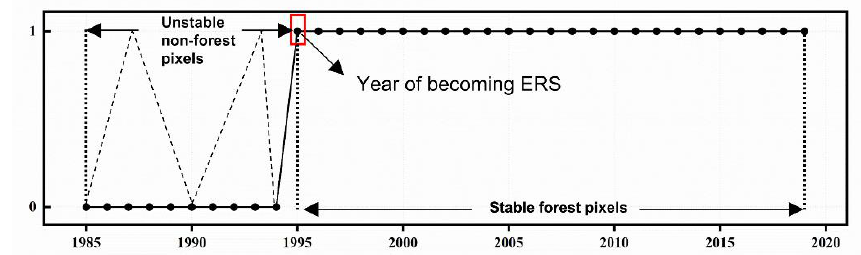
Figure 2. The schematic diagram of ERS dynamic identification method.